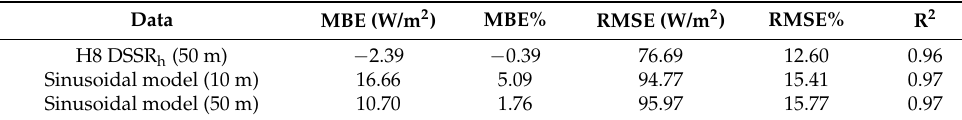
Table 4. Comparison of the DSSR accuracy estimated by the two methods with 28 ground-based measurements of AWS2 for August 17, 2018.